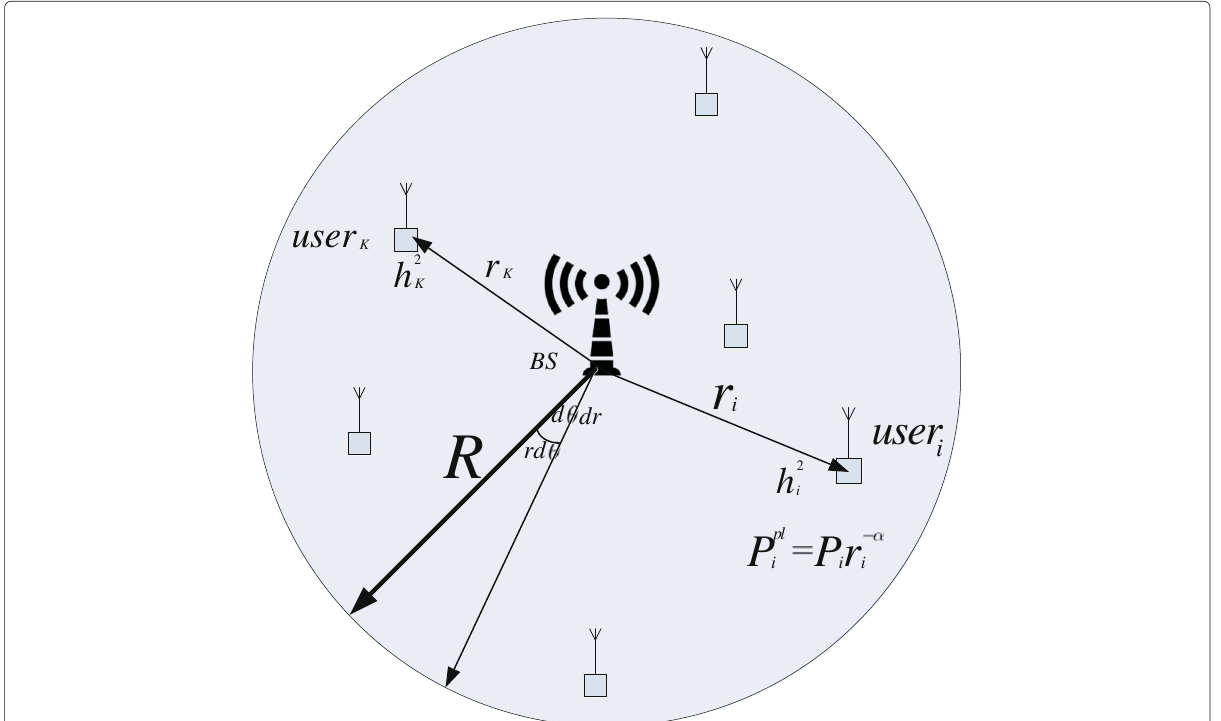
Fig. 2 Single-cell scenario with omni antenna at the BS. R cell radius, P i received power, h fading coefficient, r user distance, and K number of